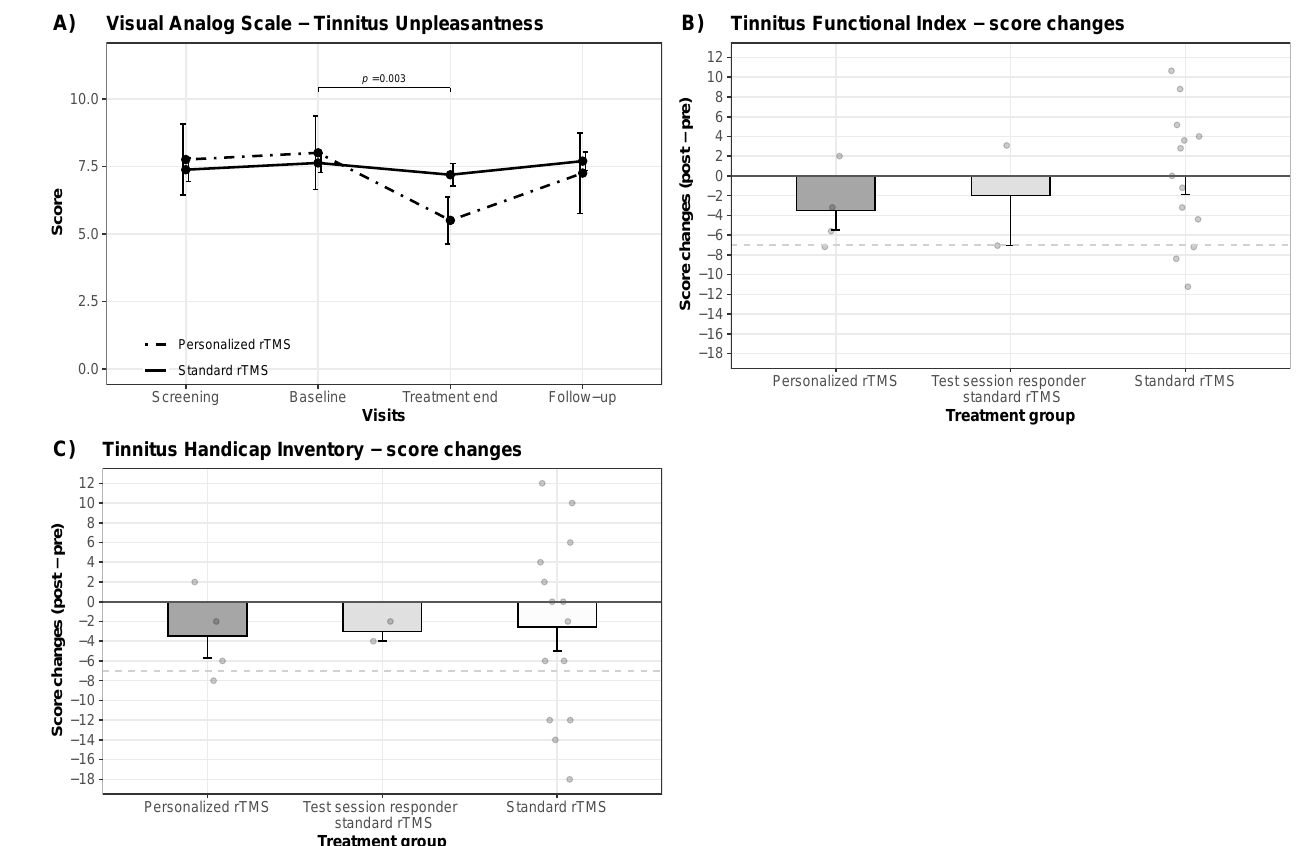
Figure 2. Personalized versus standard rTMS treatment. ( A ) Mean changes in the Visual Analog Scale for tinnitus unpleasantness are outlined for the treatment groups of standard and personalized rTMS for all study visits (screening, baseline, treatment end, follow-up). A significant alleviation from baseline to treatment end for the personalized rTMS treatment group is highlighted with bars and the respective p -value. Descriptive differences between the personalized and standard rTMS treatment group as well as test session responder receiving standard rTMS treatment are illustrated via mean score changes from baseline to end of treatment for the ( B ) Tinnitus Functional Index and ( C ) the Tinnitus Handicap Inventory. Error bars indicate standard errors. Greyish points represent mean score changes on a single patient level (TFI: 1 missing). The grey dashed line represents the cut-off for treatment response (7-point